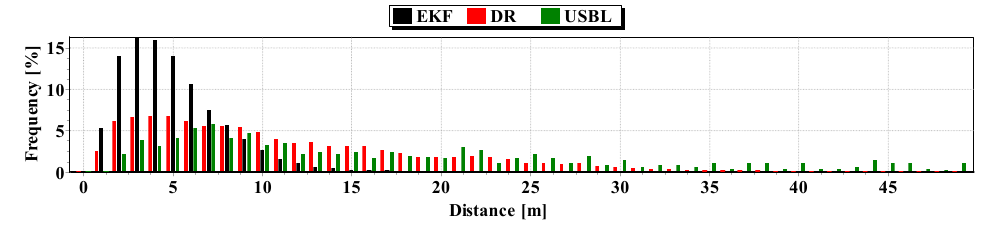
Figure 31. Graph of the reference position distance from the position estimated by EKF and DR methods and determined by the USBL system (one hundred passages).